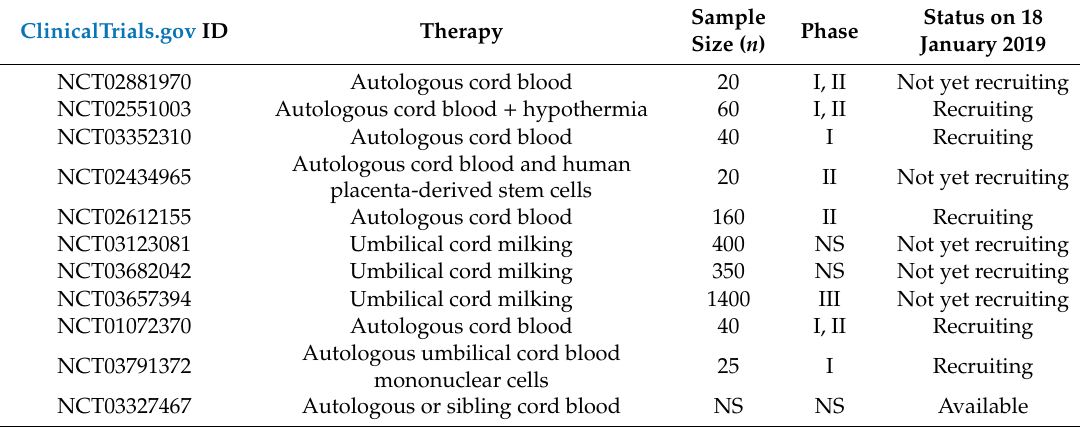
Current clinical trials assessing the use of cord blood in children diagnosed with hypoxic-ischemic encephalopathy or cerebral